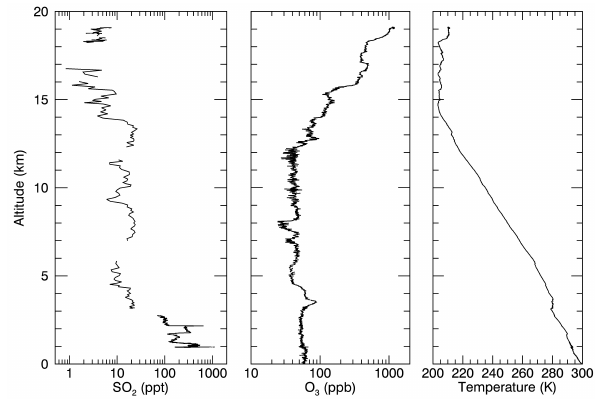
Figure 12. Data from final descent on 28 October. Left panel: 10s averages shown above 3km, 1s averages shown below 3km. Gaps in the SO 2 data are during periods where instrument calibrations and zero measurements